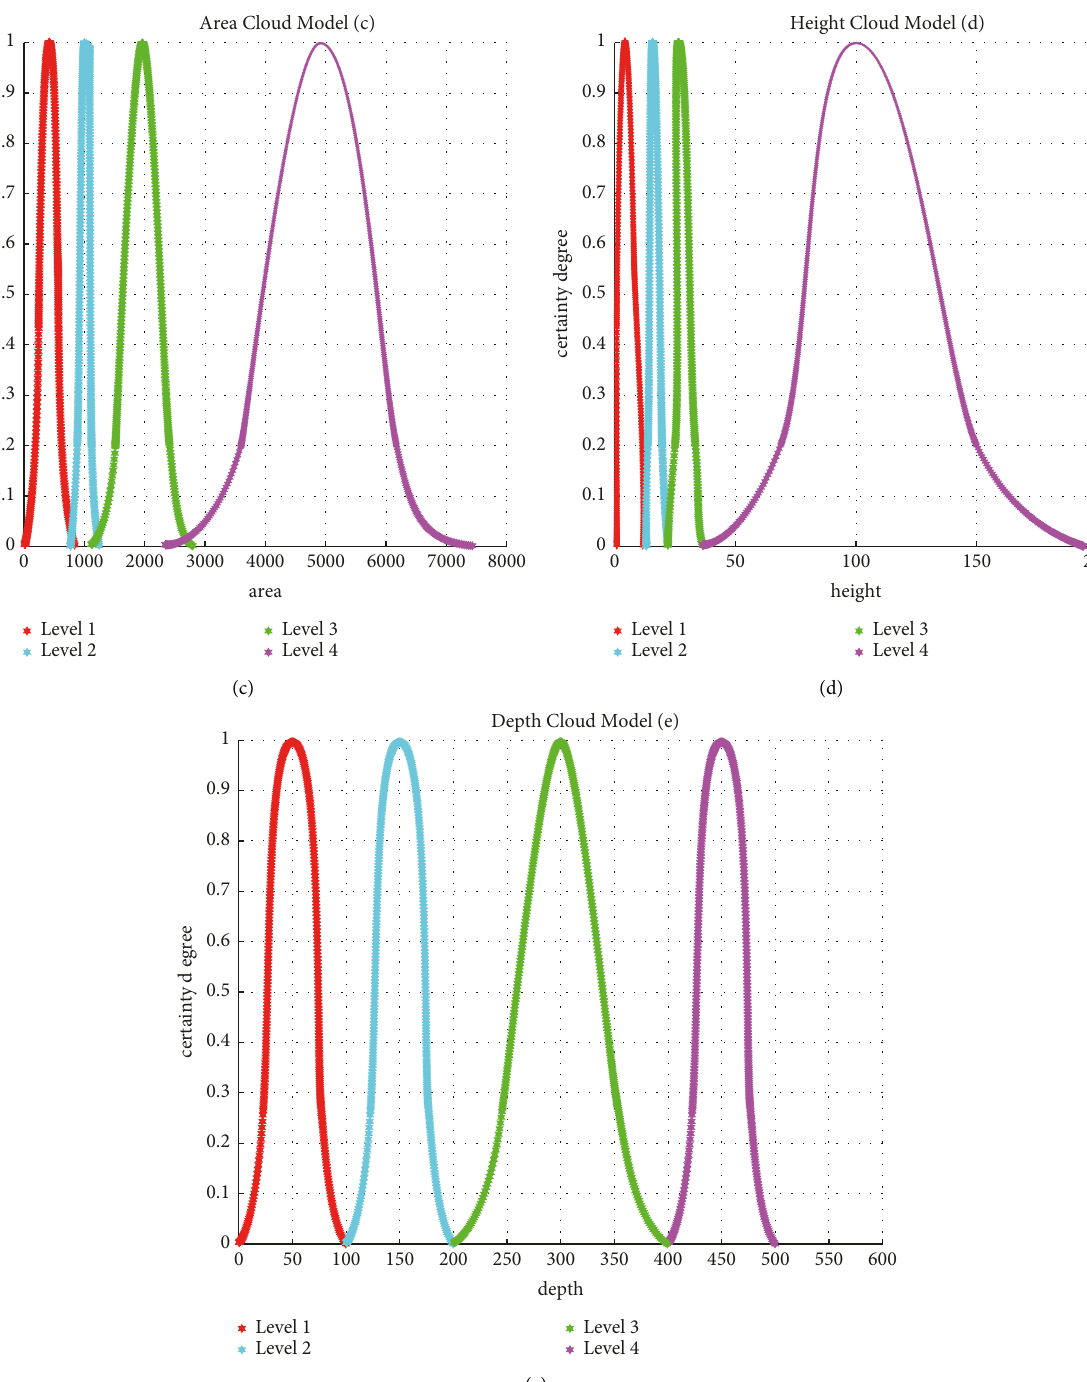
Figure 2: Each evaluation index belongs to the cloud model of the goaf stability